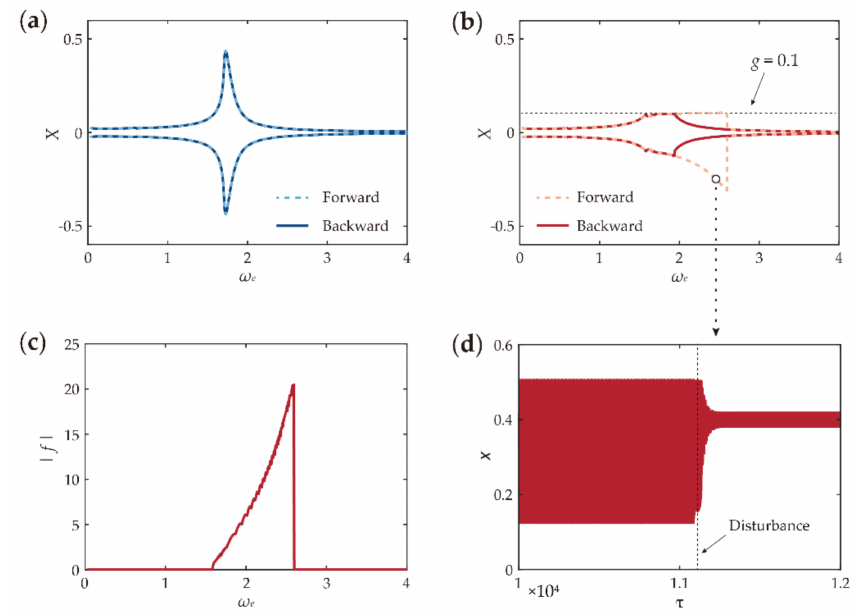
Figure 6. Frequency sweep results of the DEA ( a ) without constraint and ( b ) with constraint, φ p-p = 0.4, g = 0.1; here, X is the maximum/minimum displacement at steady state. ( c ) Impact force amplitude | f | of the resonant-impact DEA system against the excitation frequency ω e . ( d ) Demonstration of the resonant-impact DEA system losing its stability when experiencing a disturbance in its excitation voltage